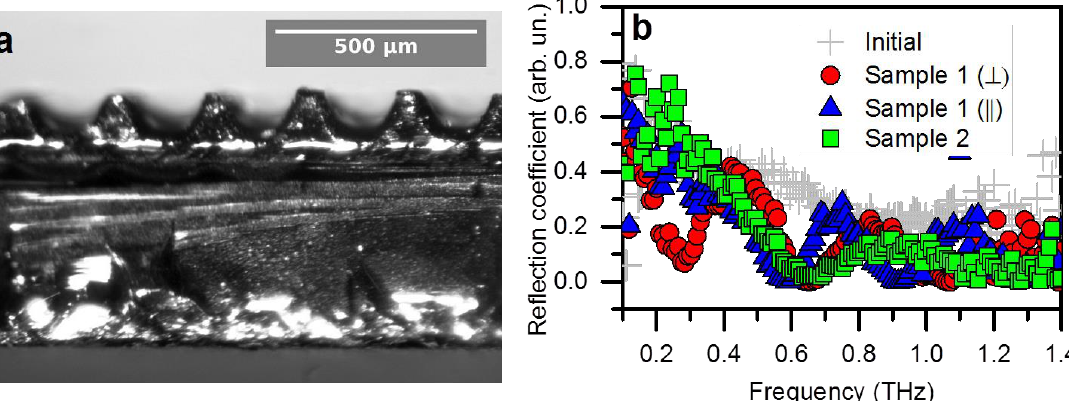
Figure 4. Optical image of Sample 1 ( a ). Reflection coefficients of Sample 1 and Sample 2 compared with epoxy-coated initial array of CNTs ( b ). Symbols ‖ and ⊥ correspond to the parallel and perpendicular orientation of engraved strips of Sample 1 relative to the polarization of the incident wave.